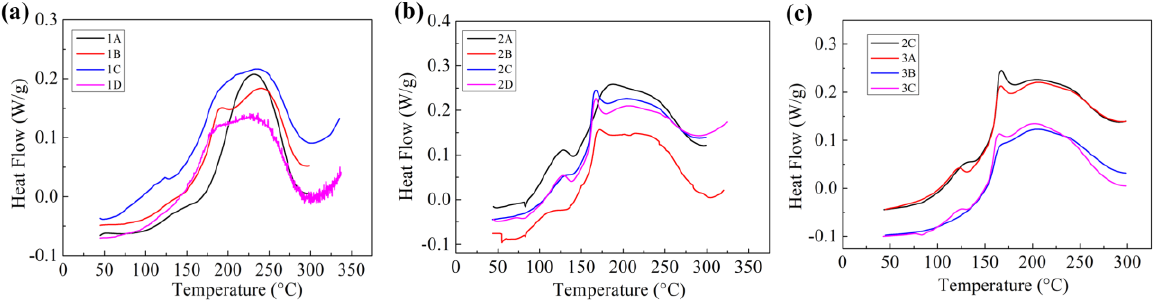
Figure 2. DSC curves of different modified BMI adhesives: ( a ) DSC curves of epoxy-modified BMI resin; ( b ) DSC curves of PEK−C-toughened epoxy-modified BMI resin; and ( c ) DSC curves of PEK−C/core–shell polymer co-toughened epoxy-modified BMI resin.